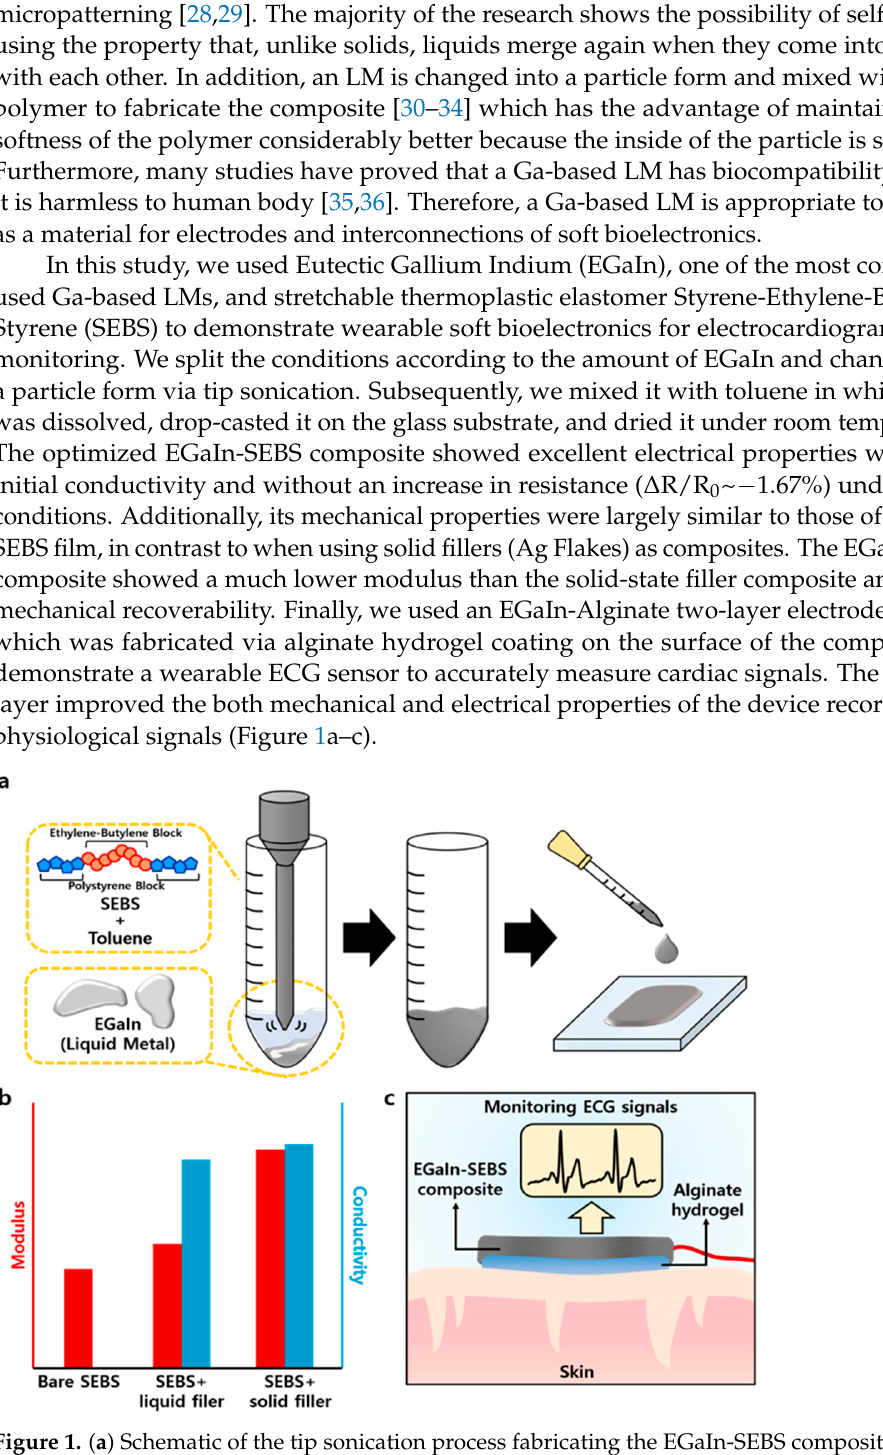
Figure 1. ( a ) Schematic of the tip sonication process fabricating the EGaIn-SEBS composite. ( b ) Bar graph comparing electrical and mechanical properties among the bare SEBS, liquid filler composite, and solid filler composite. ( c ) Schematic illustration of ECG